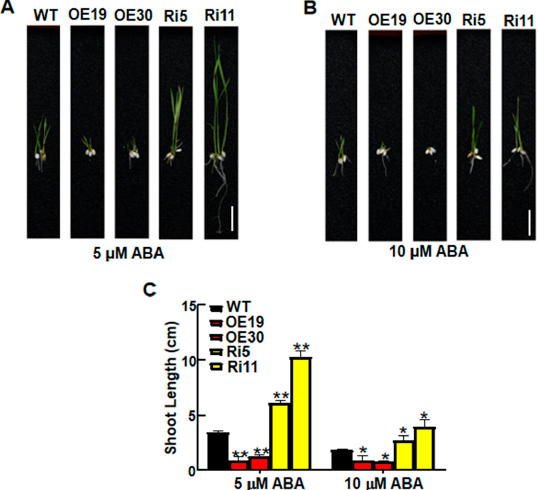
Figure 7. ABA sensitivity of WT and OsASR6 transgenic rice. Phenotypes of wild-type (WT) and OsASR6 transgenic seedlings following treatment with ( A ) 5 and ( B ) 10 µ M ABA (scale bar: 3 cm). ( C ) Shoot lengths following each treatment. Asterisks indicate significant differences between means of WT and transgenic lines. Data represent means ± SD ( n = 30). * p < 0.05, ** p < 0.01. To determine the possible regulatory mechanism of OsASR6 in ABA signaling, yeast